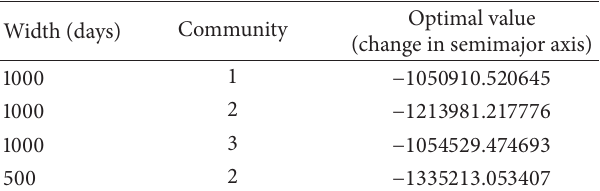
Table 11: Relationship between partition width and optimal value.